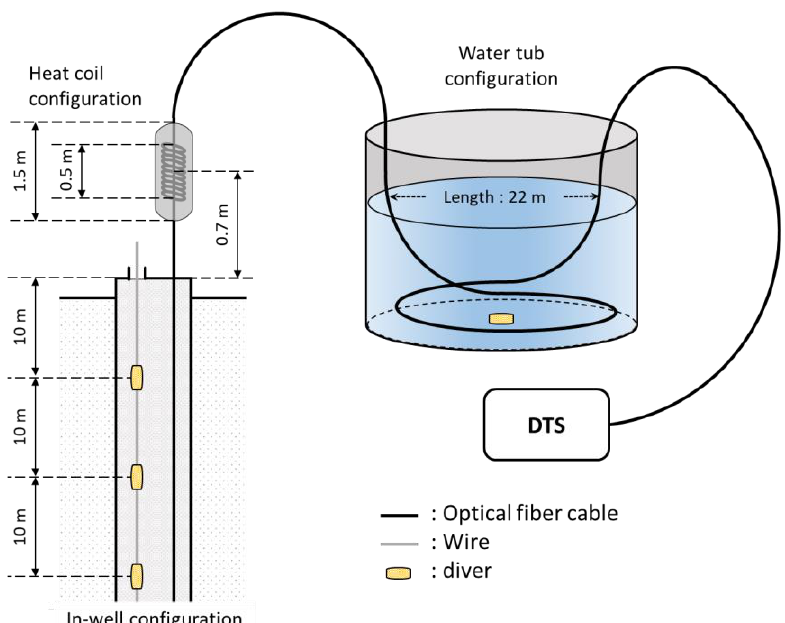
Figure 6. Schematic diagram and setting of three temperature calibration experiments.